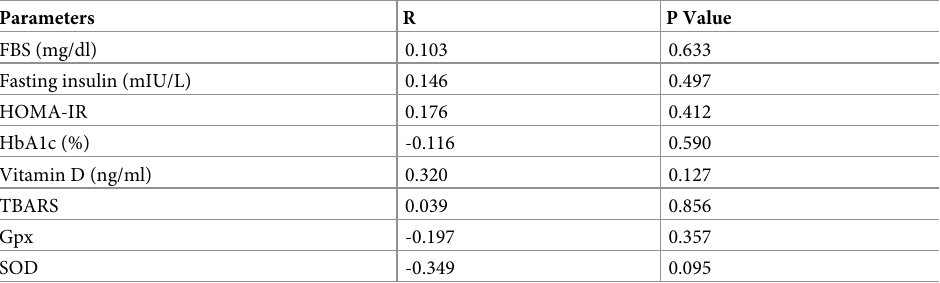
Table 7. Correlation between 3MS score and various biochemical parameters among diabetic subjects with vita- min D